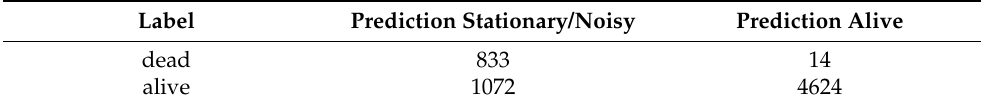
Table 5. Results obtained by applying the initial detection algorithm to the original dataset.